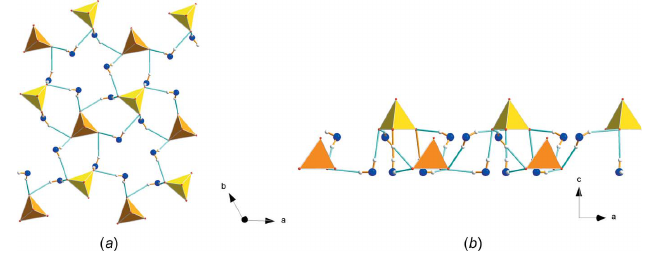
Figure 12 Larger part of the hydrogen-bond network projected on ( a ) the ab plane and ( b ) the ac plane.